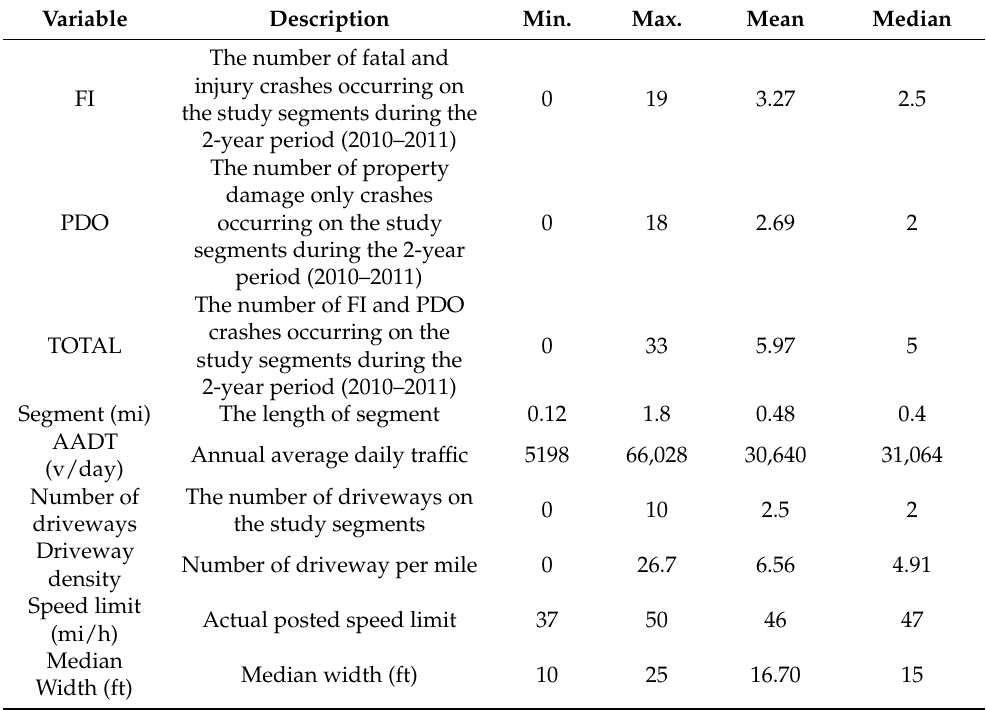
Table 1. Descriptive Statistics of